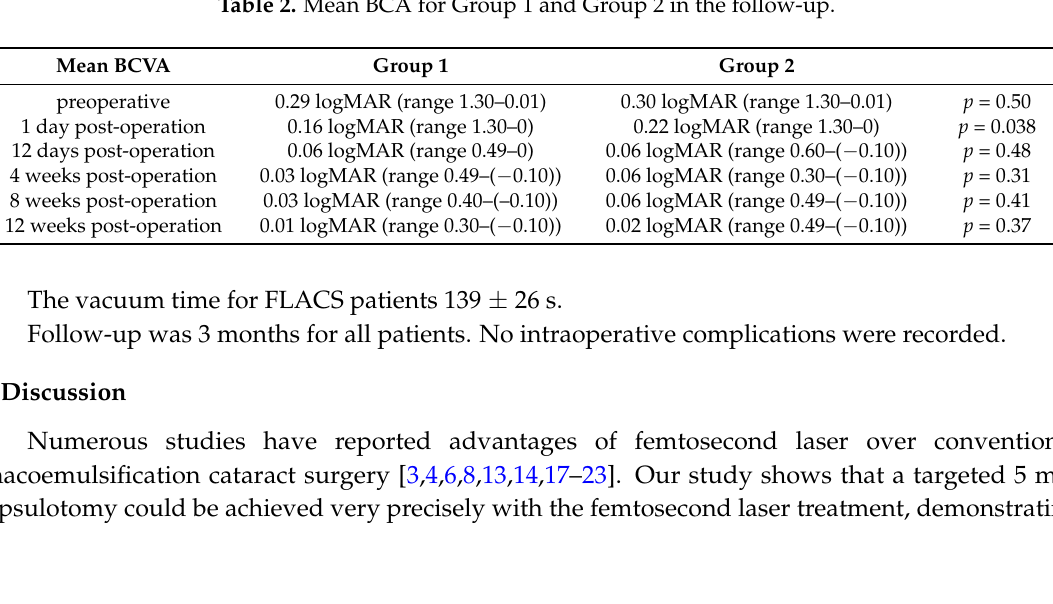
Table 2. Mean BCA for Group 1 and Group 2 in the